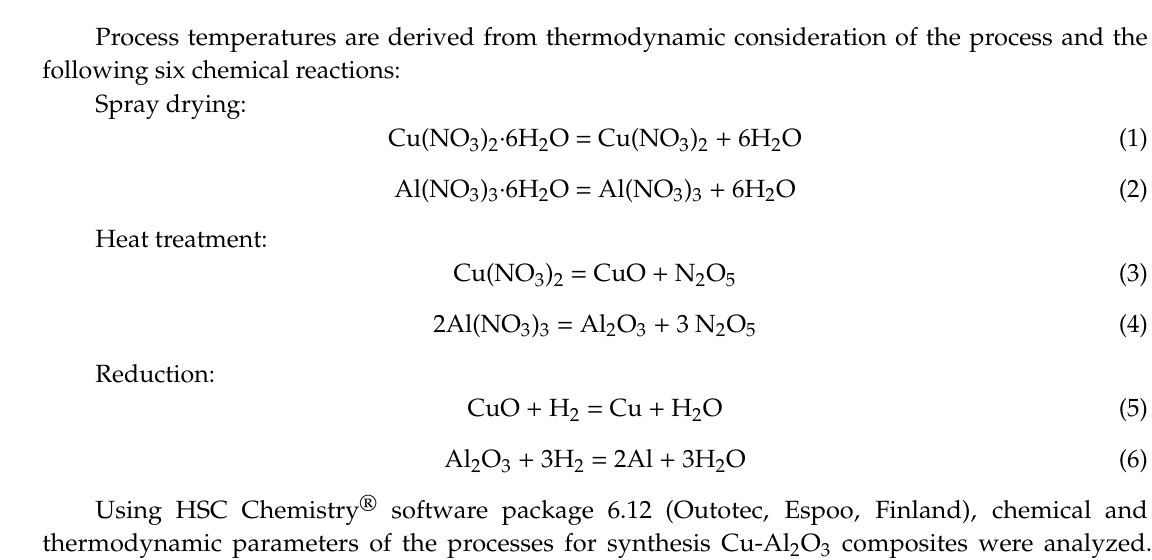
Figure 1. Flowsheet of the synthesis of Cu-Al 2 O 3 nanocomposite powder by the thermochemical procedure [28].